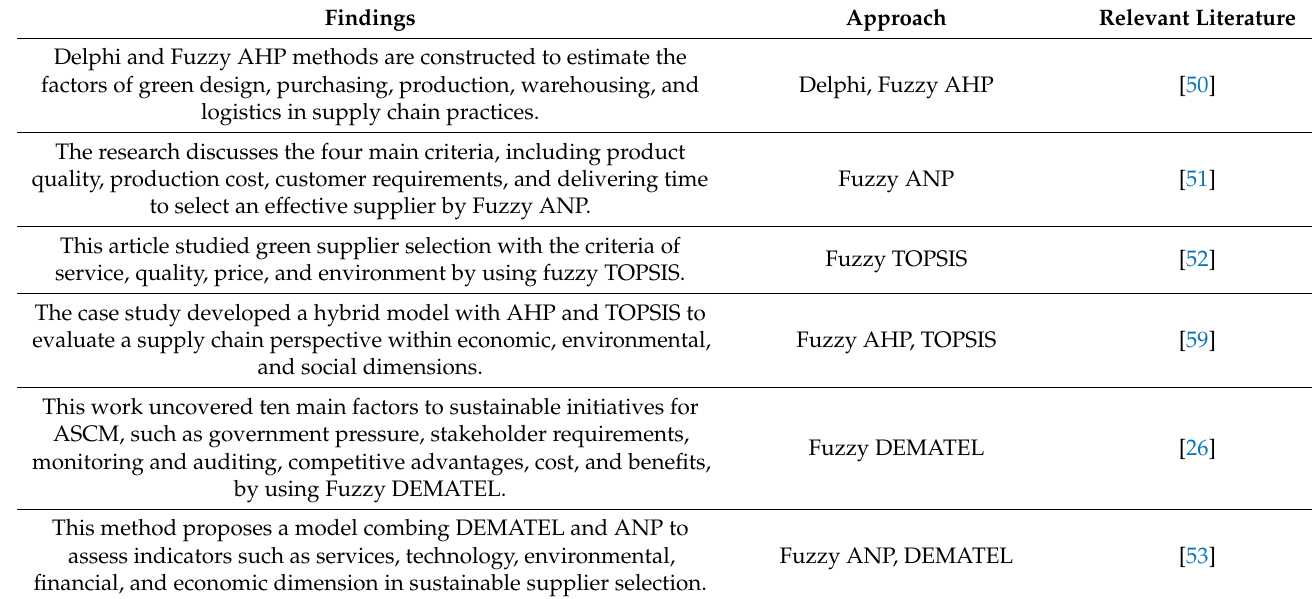
Table 1. Overview of relevant studies with MCDM